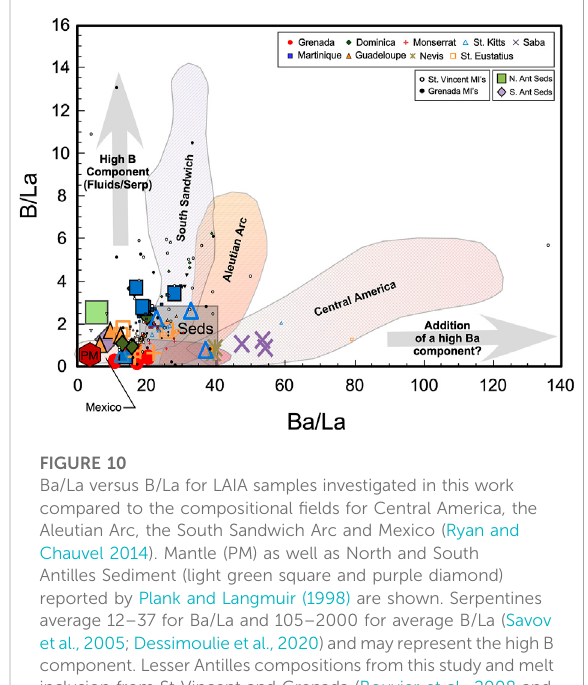
FIGURE 11 Plotshowingtrendscausedbydehydrationofthesubducting slab (vertical trends) versus sediment melting (horizontal trend) in relation to LAIA samples. The Central Islands of Martinique, Dominica, Guadeloupe as well as the southern island of Grenada all plot along a proposed sediment melting trend while the northern islands of St Eustatius, St. Kitts Saba, and Nevis all plot at increasing Ba/Th. Both trends seem to originate from primitive mantle values (PM) and are compared to binary mixing curves (afterLangmuir,1978)trendingtoSite543(purpledot-dashedline) and Site 144 (green dashes).Compositions for thenorthern islands can be reproduced without requiring slab dehydration via binary mixing between mantle and a Site 144 “ like ” sediment but with elevated